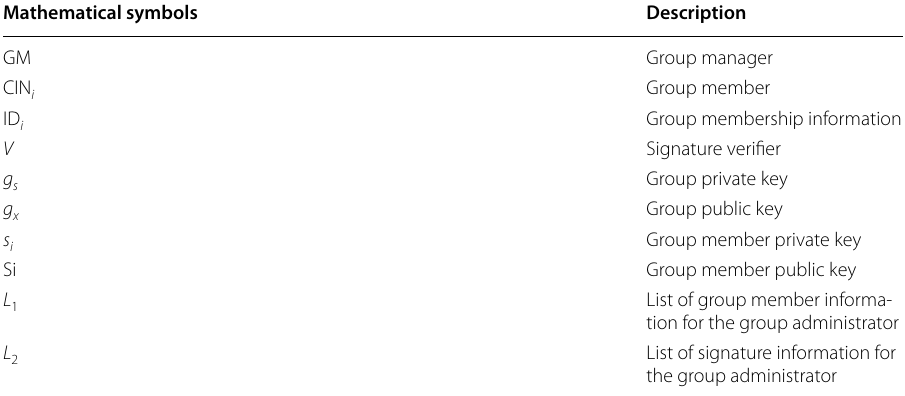
Table 1 Symbol description of GS‑RAM scheme Mathematical